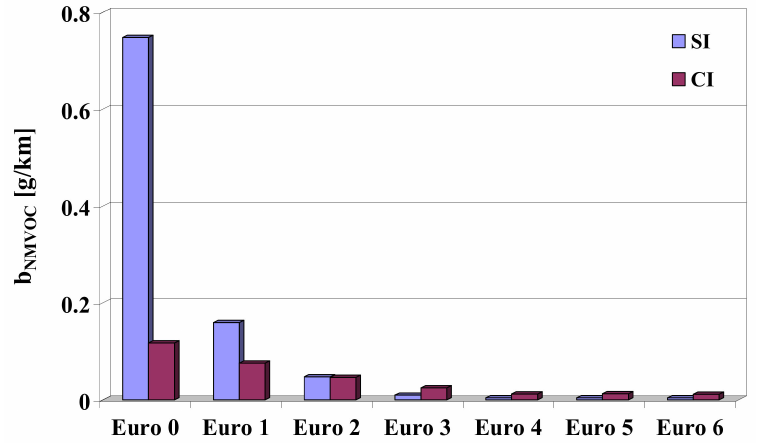
Figure 13. Specific distance emission of non-methane volatile organic compounds—b NMVOC , from hot passenger car engines of Euro 0–Euro 6 pollutant emission categories, spark-ignition engines—SI and compression-ignition engines—CI, under the model vehicle traffic